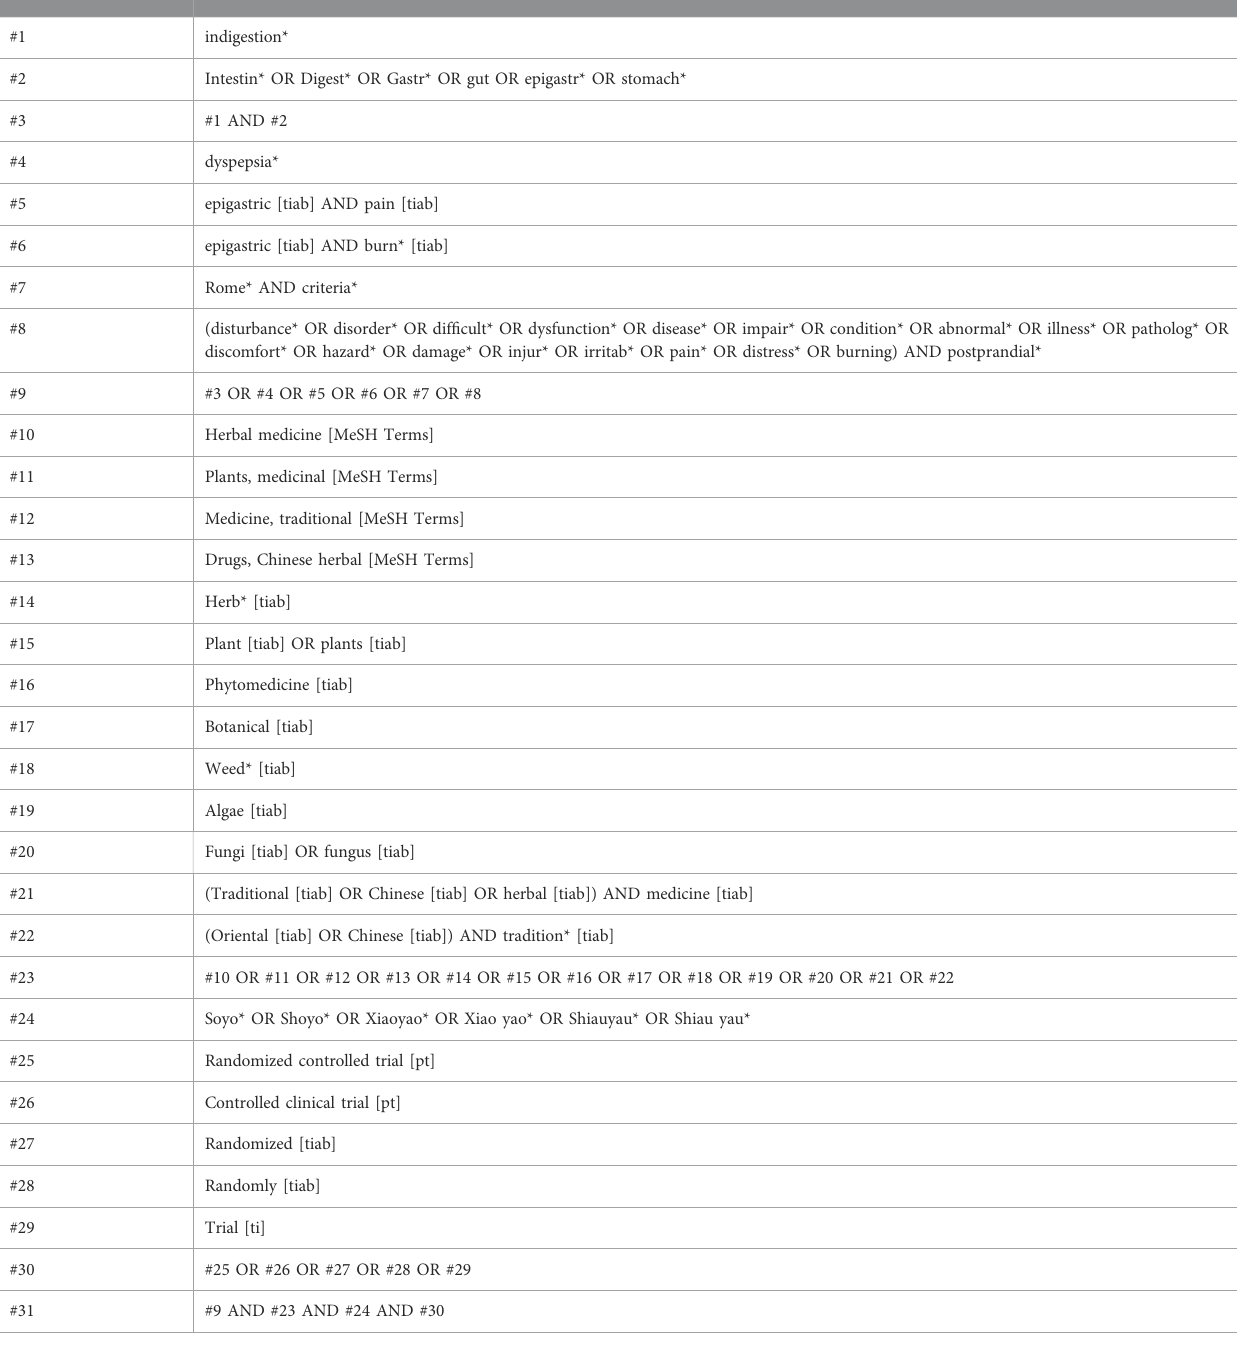
TABLE 1 Search strategy used in Medline via